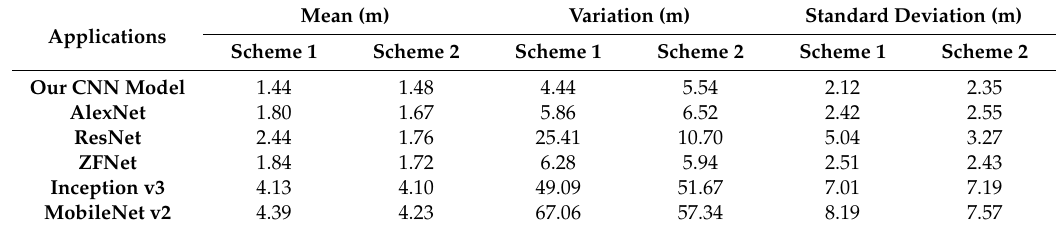
Table 8. The performance statistics of CNN application models trained on RSSI datasets.